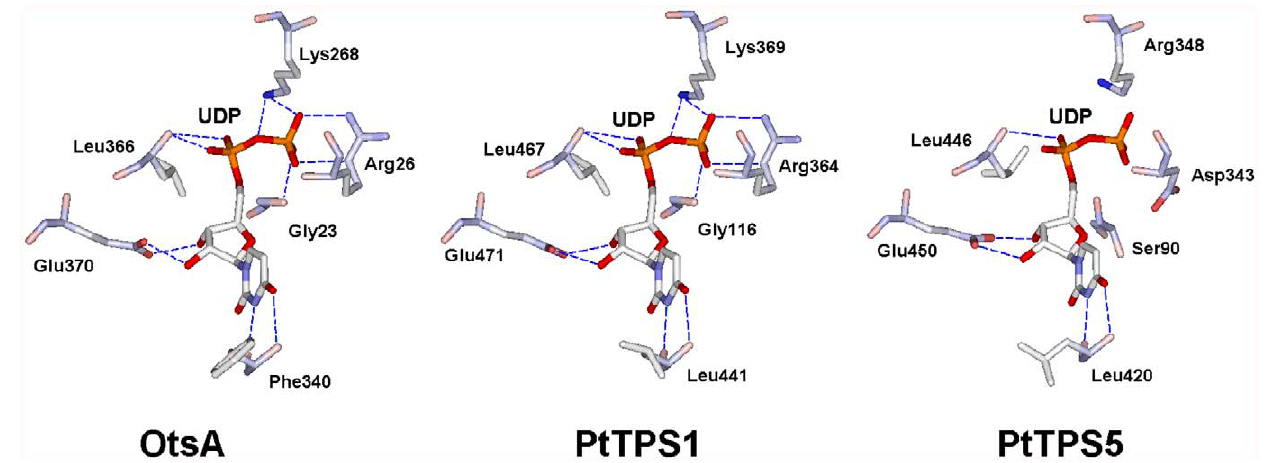
Figure 3. Schematic diagram of the interactions between UDP-glucose and TPS proteins.